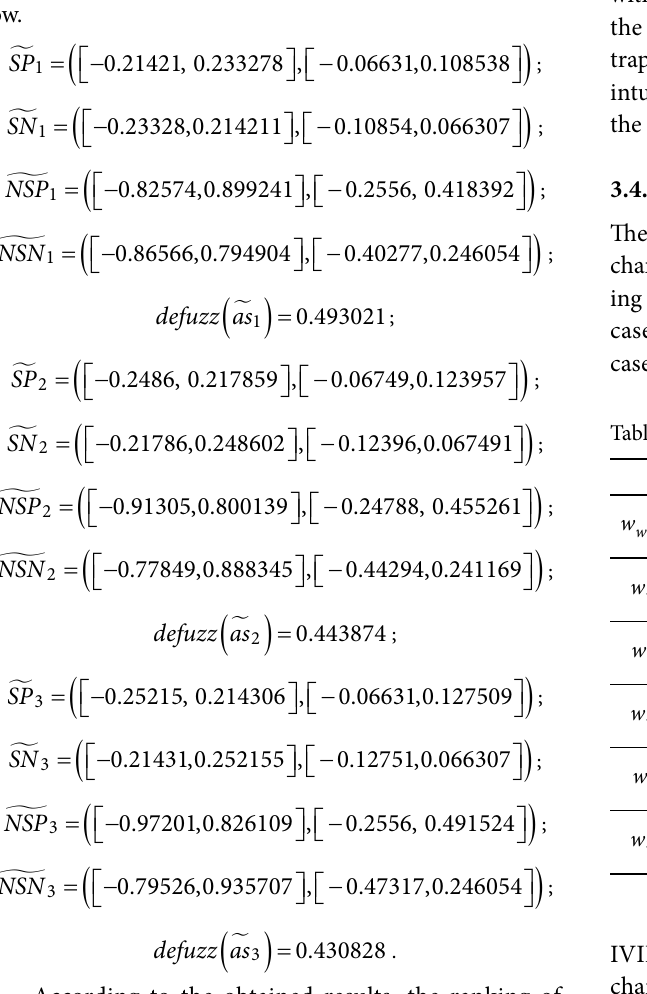
Table 10 indicates that the ranking result obtained by IVIF EDAS is very robust. From slight changes to extreme changes in criteria weights, SWDS-1 is selected without any doubt. Smaller weights of the criterion “water pol- lution ( W )” cause the scores of alternatives 2 and 3 get closer.